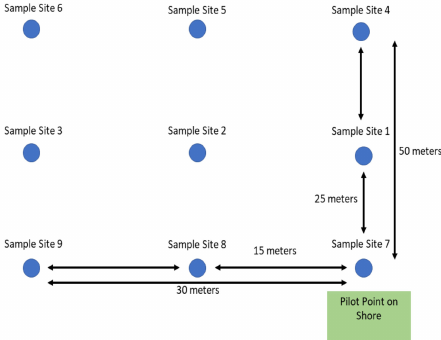
Figure 3. Schematic of sampling plan for each of the lakes in Austria. All distances were measured in flight using GPS coordinates in the DJI GO 4 software. The lower right corner of the sampling grid was designated as the pilot start point and served as the take-off and landing site for all sample